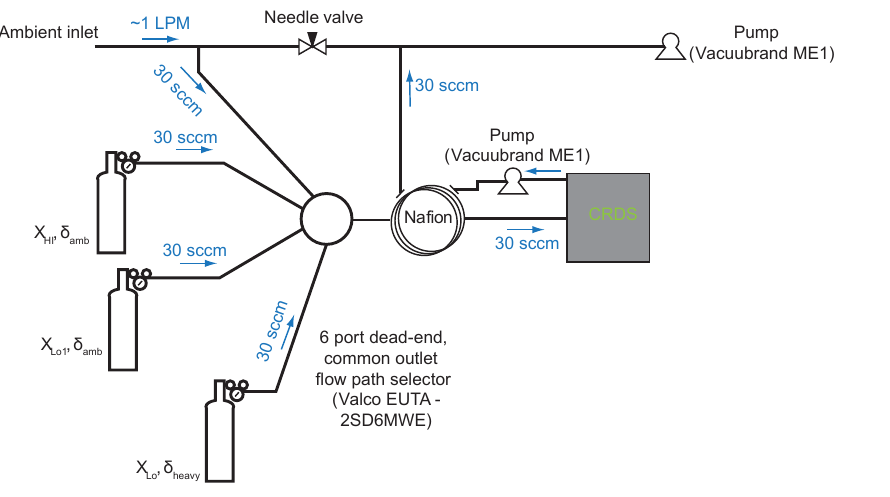
Figure 6. Flow diagram of the field calibration system. At standard pressure and temperature, the gas volume of the field tanks was 4021L.